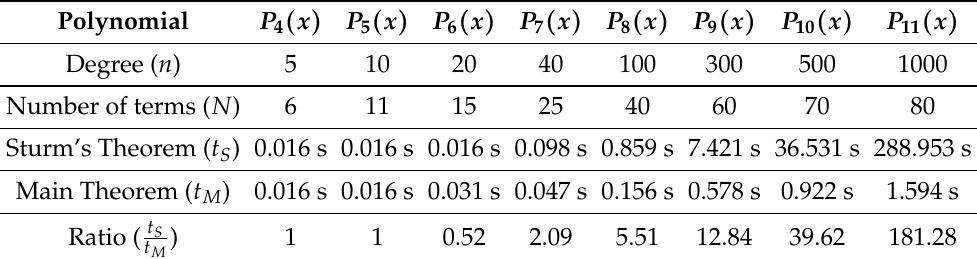
Table 1. Comparison of CPU running speed between Sturm’s Theorem and Main Theorem.